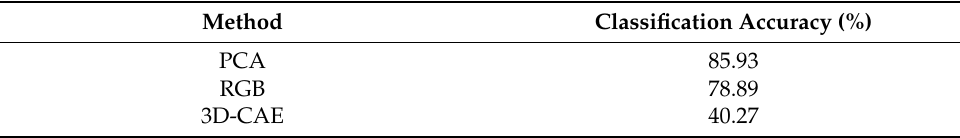
Table 2. Classification accuracy of the three methods proposed in the study.